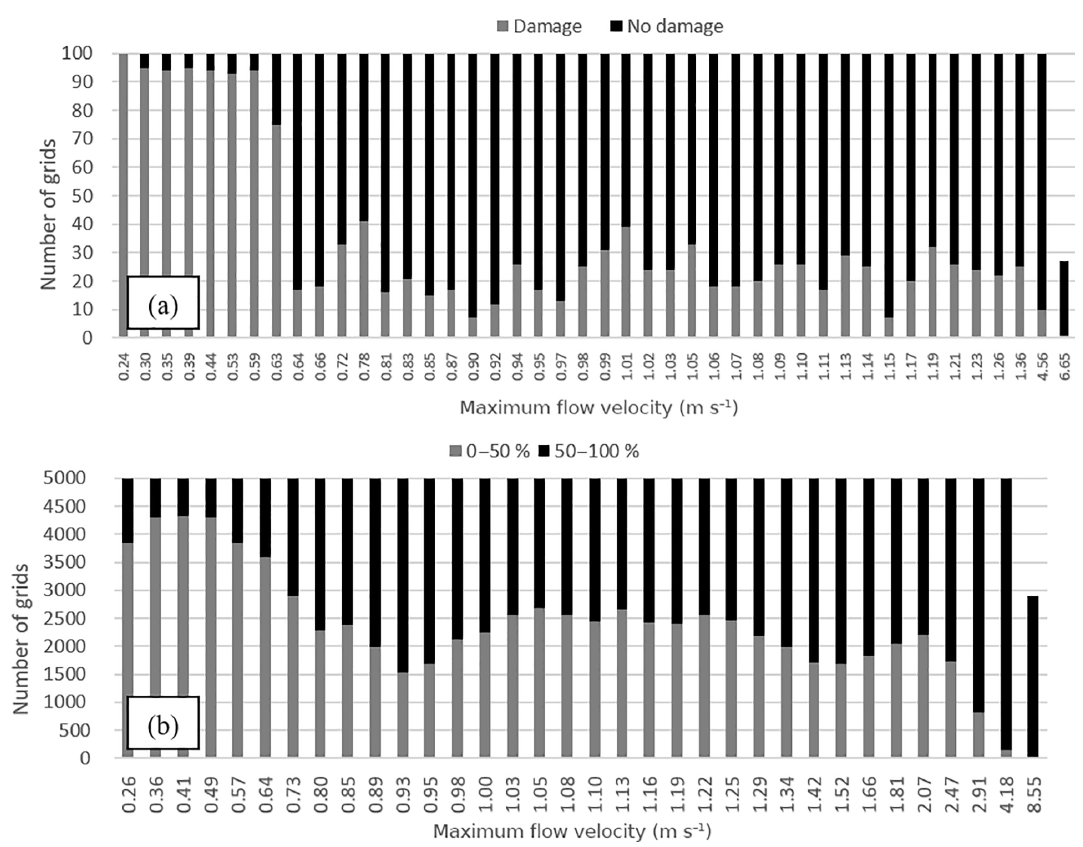
Figure 13. Histogram of the numbers of (a) damaged and undamaged aquaculture rafts and (b) 0–50% damaged and 50–100% damaged eelgrass in terms of the simulated flow velocity range in Mangokuura Lake.